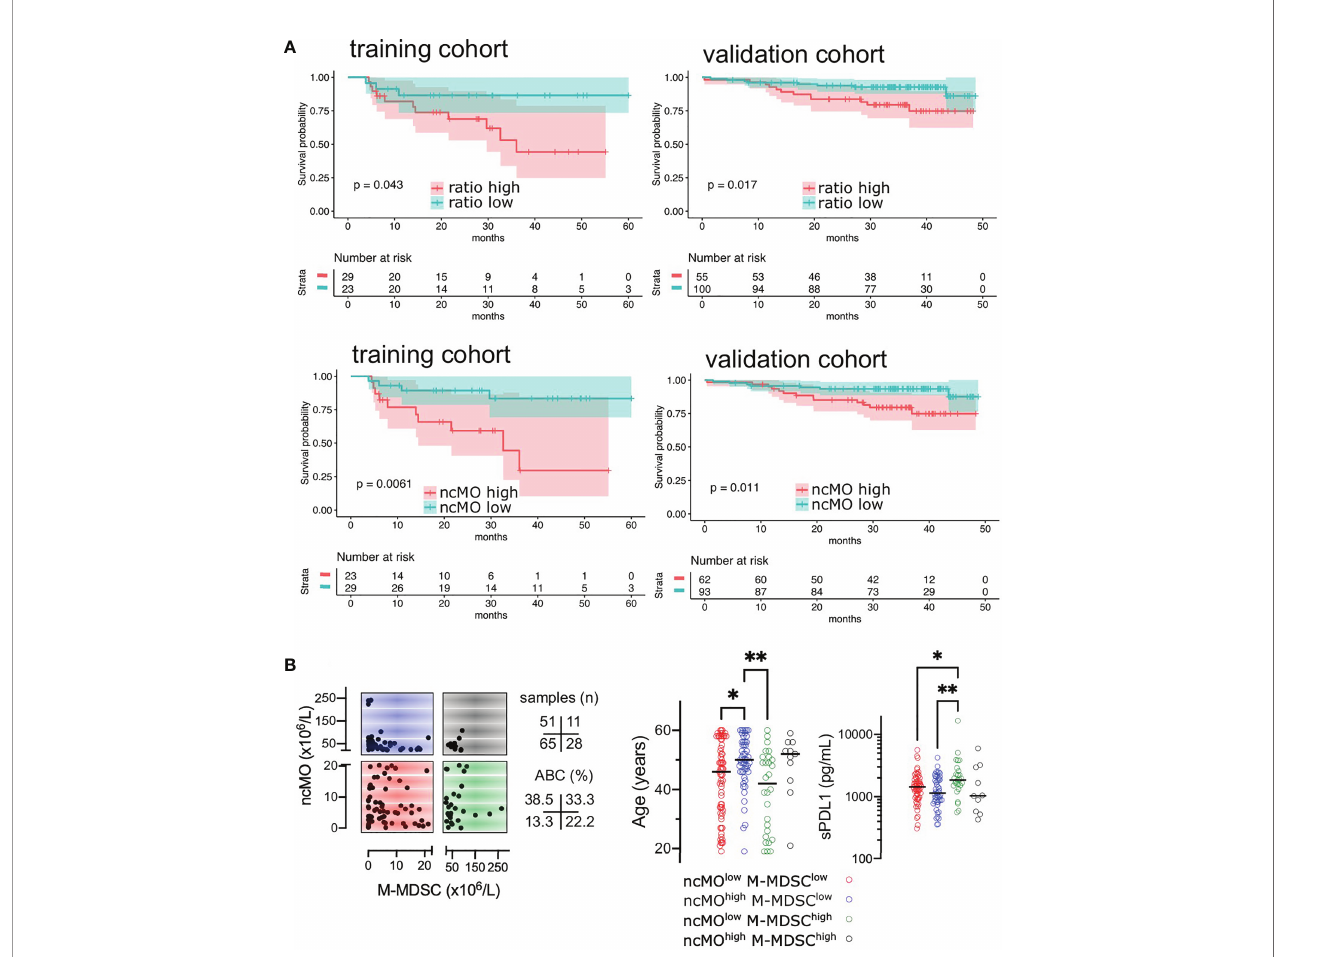
FIGURE 5 | High levels of circulating ncMO is correlated to adverse prognosis in DLBCL. (A) Event-free survival (EFS) in training cohorts (NCT01287923) and overall survival (OS) in validation cohorts (NCT01659099) (24). Patients were strati fi ed on the ratio of ncMO to other monocytes (cMO and iMO) and on the absolute count of circulating ncMO. Threshold was de fi ned on the training cohort using the maxstat package ( Figure S7 ). Survival probability was calculated for both groups with a log-rank test. (B) Absolute count for ncMO (threshold at 20.58 x10 6 cells/L) and M-MDSC (threshold at 22.51 x10 6 cells/L) (22), and distribution of age and soluble PD-L1 (sPD-L1), *P < .05, **P <